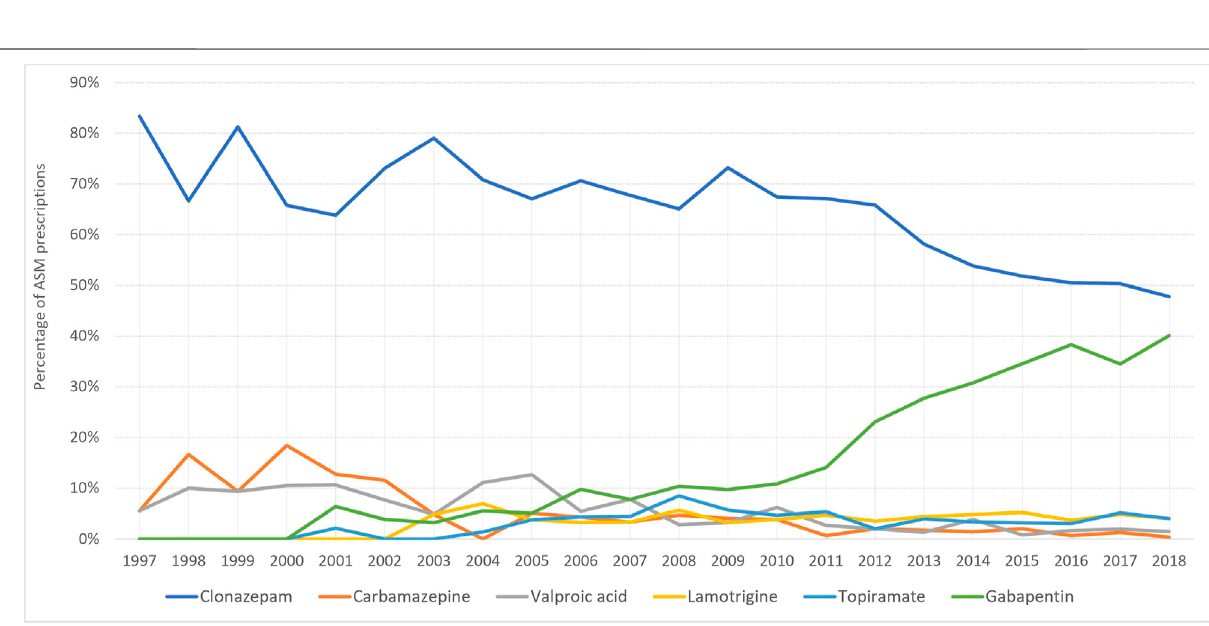
FIGURE 5 | Trends of top ASM prescriptions among pregnant women without